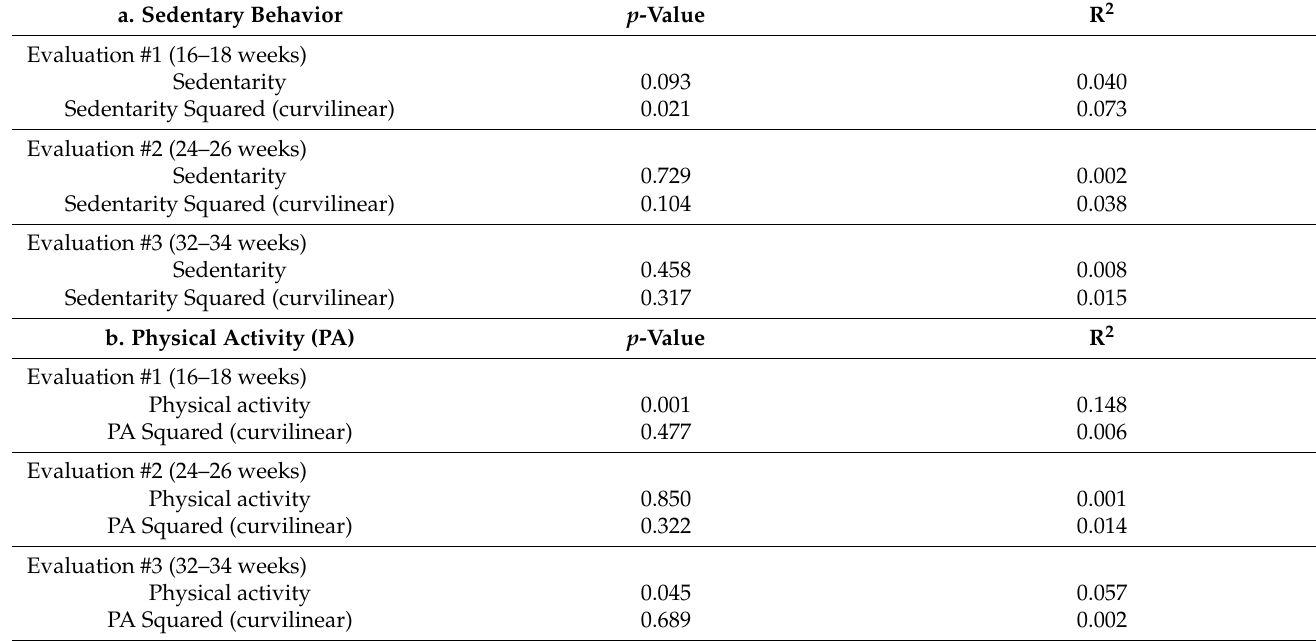
Figure 2. Relationships between sedentary behavior ( a ) and physical activity ( b ) at 16–18 weeks gestation with birthweight-for-gestational age Z-scores (BW-for-GA).